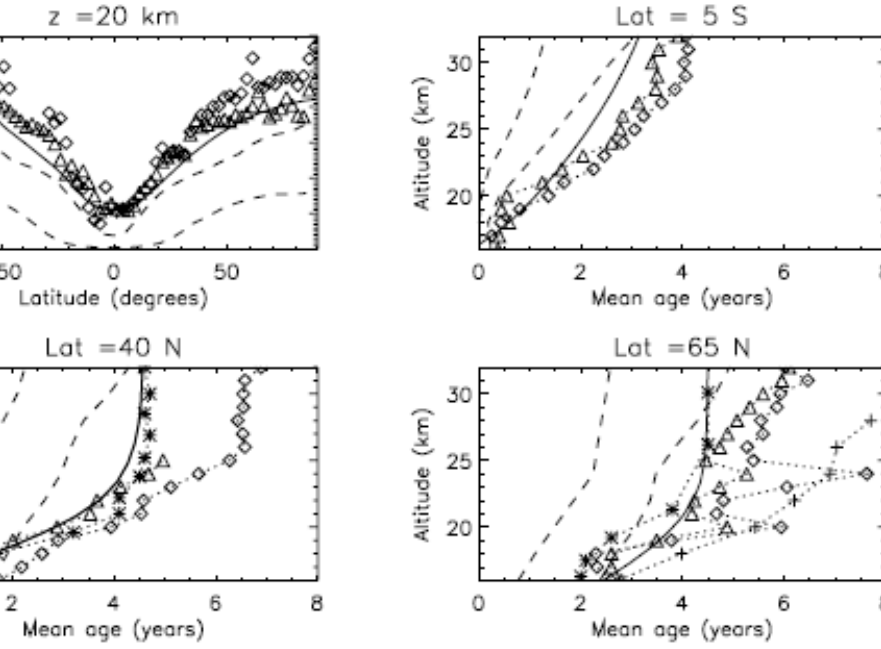
Fig. 4. Annually and zonally averaged mean age of air relative to the equatorial tropopause and after 20-years of the LMDz-REPROBUS simulation (see text for details). (a) Latitude-altitude section, the dotted thick line indicates the thermal tropopause and the contour interval is 0.5 year.; (b) Latitudinal variation at the altitude z =20km. (c) vertical profile at the latitude 5S, (d) vertical profile at the latitude 40N, and (e) vertical profile at the latitude 65N. In (b), (c), (d), and (e) the solid line is for the model values while the various symbols are derived from observations: in situ CO 2 (triangles) are from Boering et al. (1996) and Andrews et al. (2001b), in situ SF6 (diamonds) are from Elkins et al. (1999), Ray et al. (1999) and SF6 whole-air samples are from Harnish et al. (1996) (asterix outside the vortex and crosses inside the vortex). See also Hall et al. (1999) for details on those measurements. The dashed lines represent the range of most models involved in the Models and Measurements II project (Hall et al., 1999).